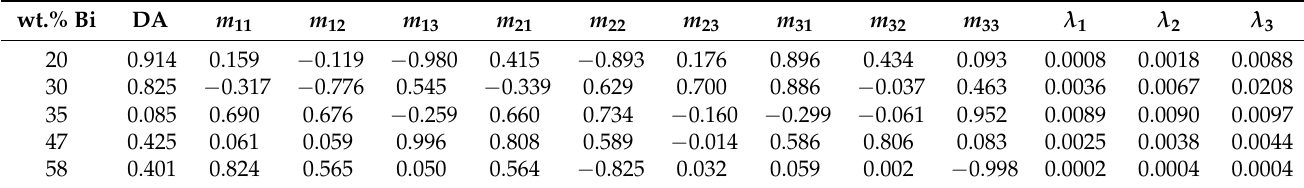
Table A1. Degree of anisotropy, eigenvectors m ij and eigenvalues λ i of ellipsoid fit. wt.% Bi